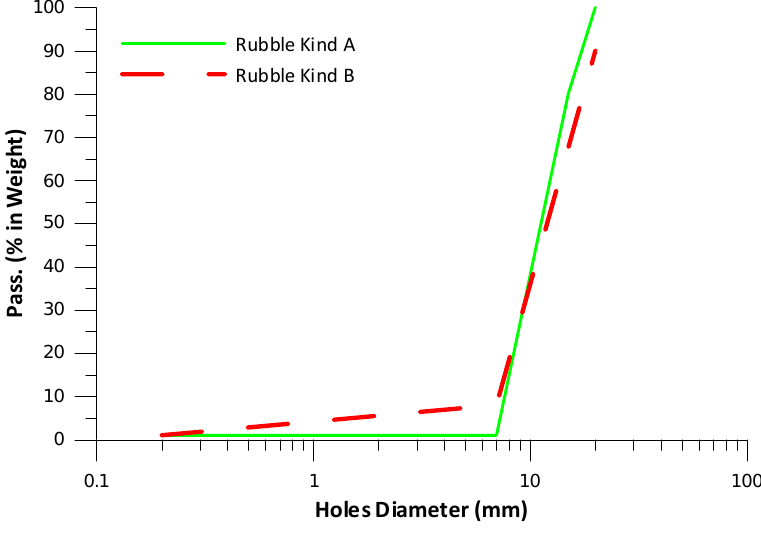
Figure 3. Granulometric curves of rubble.